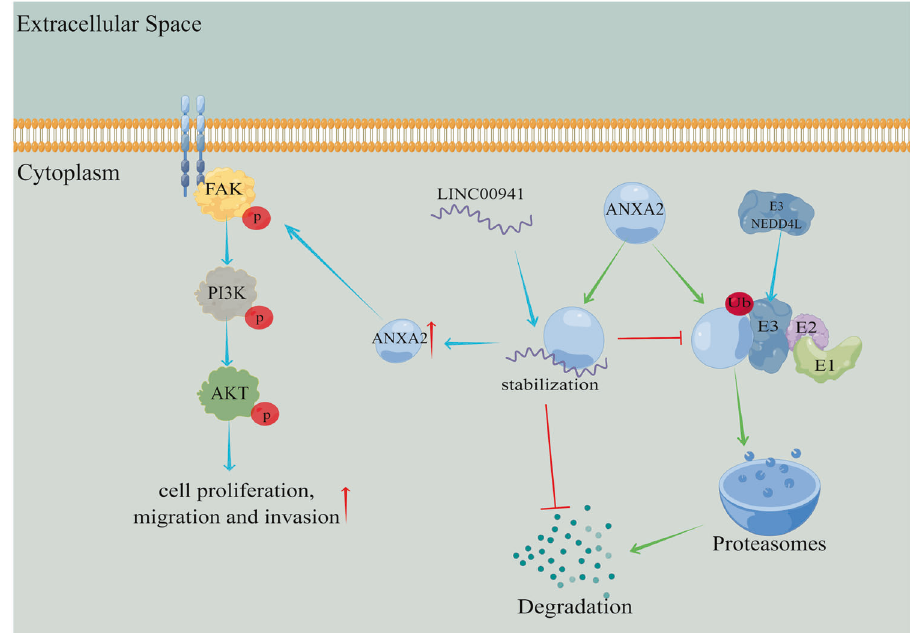
Fig. 8 The schematic diagram of LINC00941 promoting pancreatic cancer progression. LINC00941 acts as a decoy to interact with ANXA2, blocking the key interaction domain between NEDD4L and ANXA2, inhibiting ubiquitin-mediated degradation of ANXA2. Eventually, LINC00941 stabilizes ANXA2 and promotes activation of FAK/AKT signaling, resulting in facilitating pancreatic cancer proliferation, migration, and invasion (the fi gure was drawn by Figdraw,